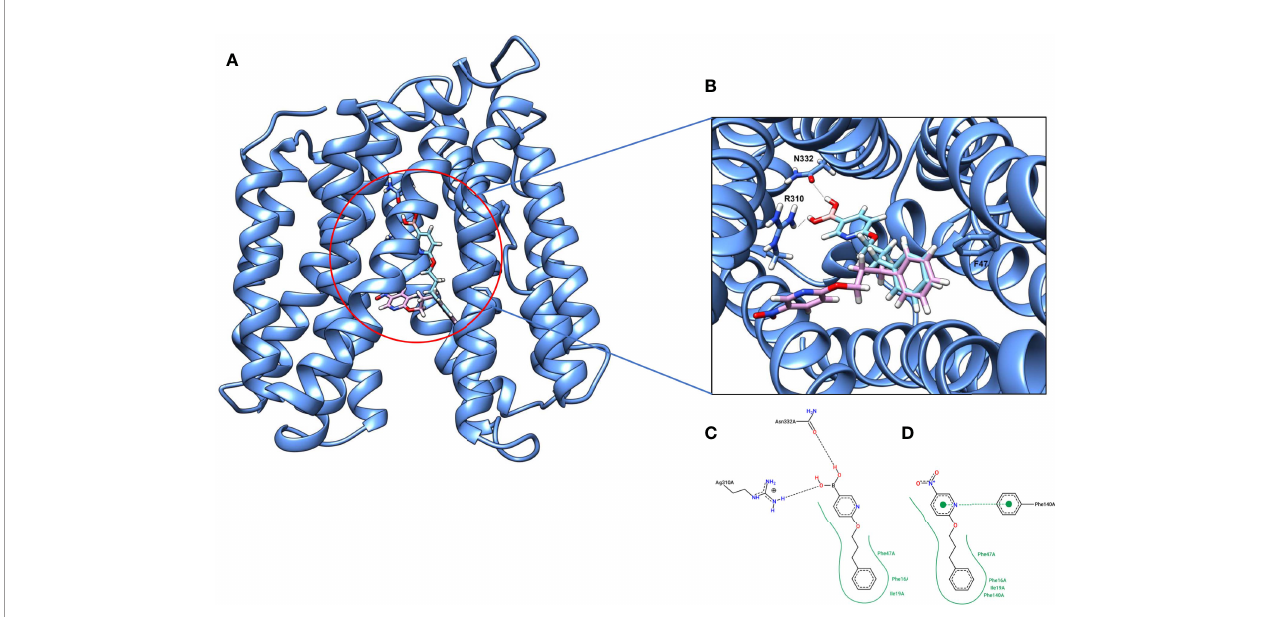
FIGURE 2 | (A) Hypothetical binding mode of 5-NPPP at the hydrophobic cleft of the NorA ef fl ux pump (blue). The ligand is represented in a multicolor stick model. (B) The binding interactions of 6-(3-phenylpropoxy) pyridine-3-boronic acid and 5-NPP with the binding site amino acids. (C) 2D-interaction map of 6-(3-phenylpropoxy) pyridine-3-boronic acid with the NorA ef fl ux pump. (D) 2D interaction map of 5-NPPP with the Nor A ef fl ux pump in hydrophobic cleft with Phe47, Phe16, Phe140, and Ile19 enables a stronger hydrophobic interaction due to the closer proximity of the ligand with these residues as well as possessing p – p